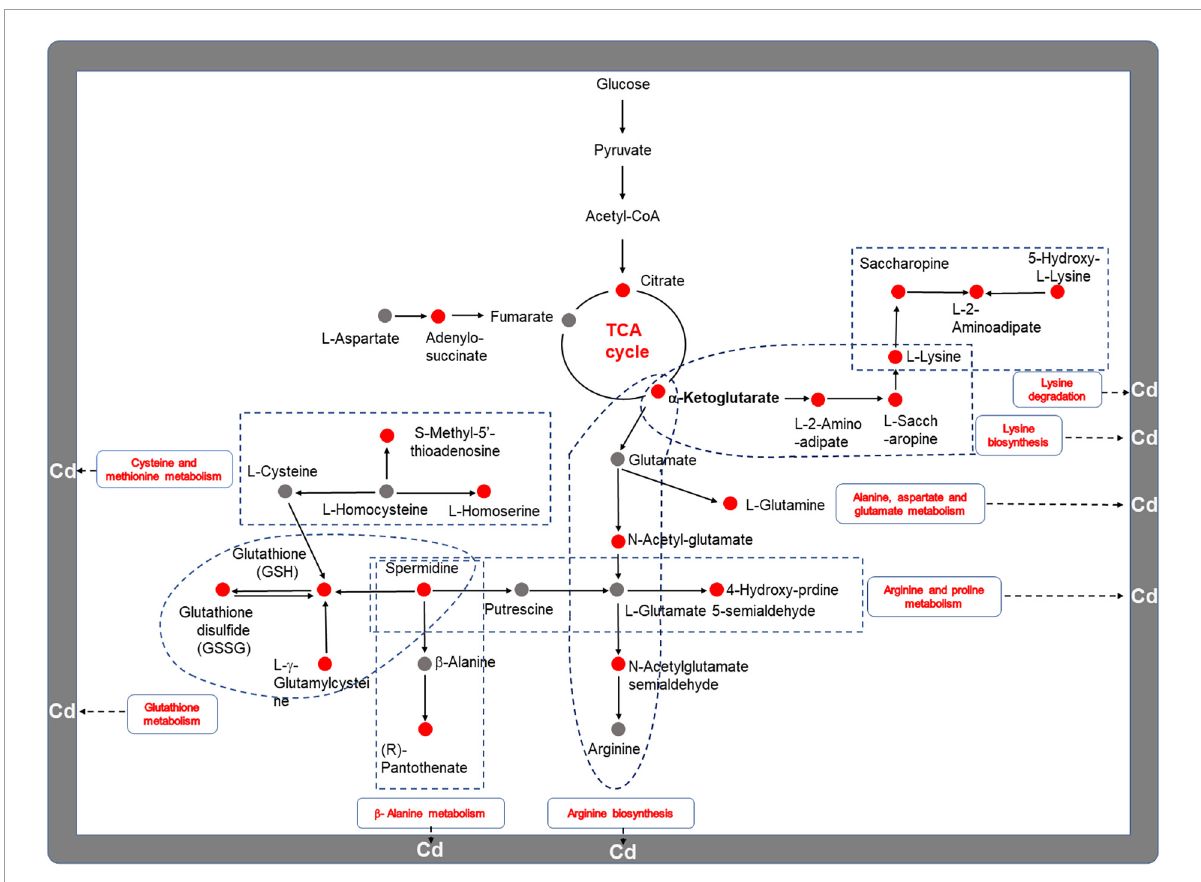
FIGURE7 The underlying mechanism of T. pubescens defenses against Cd toxicity. The red color represents upregulated metabolites or metabolic pathways. The gray color indicates the metabolites that were not annotated. Cd, cadmium; Cd_L, low-dose Cd treatment group; CON, no Cd treatment